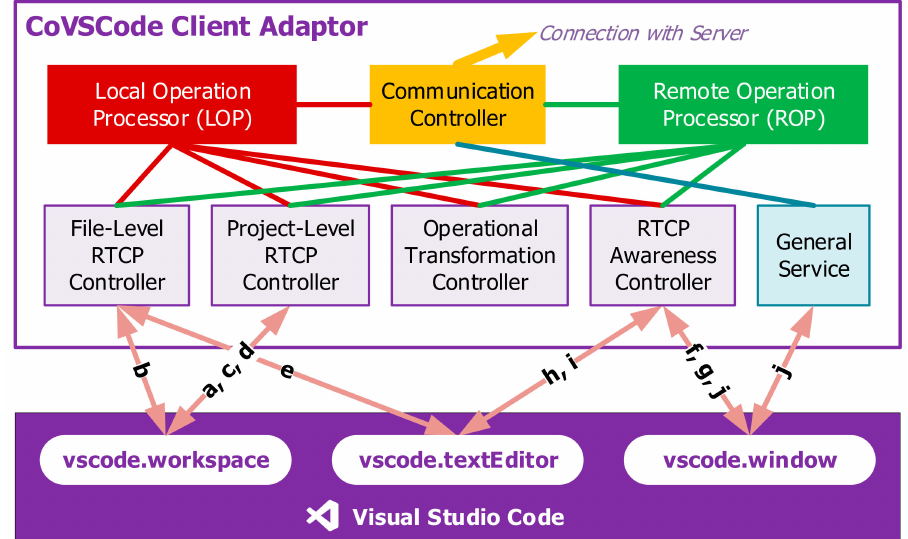
Figure 3. The CoVSCode client system architecture and major functional